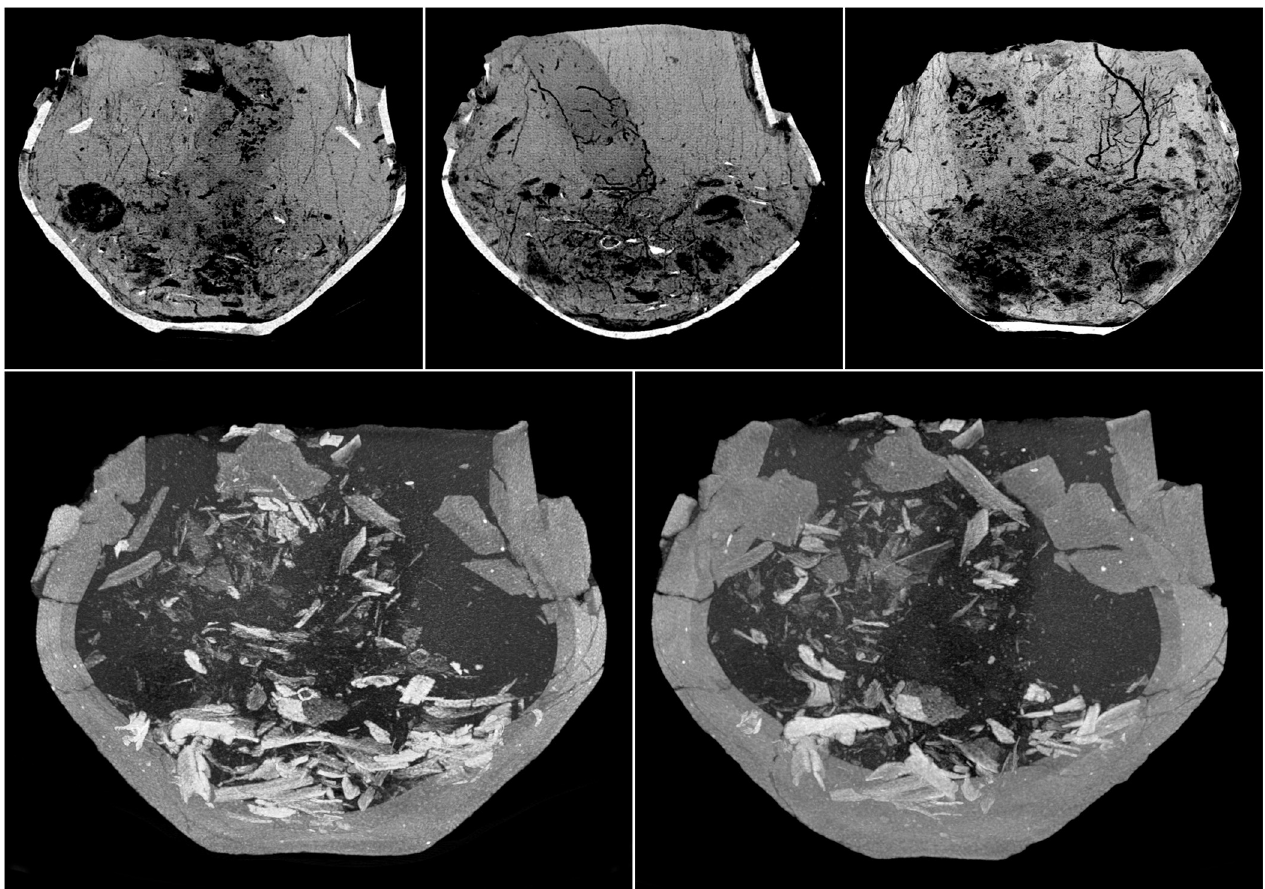
Fig 12. The CT imaging of the fill of the urn from grave 877. The top row shows the MinIP reconstruction of the urn fill with a visible system of burrows and ingrown plant roots. At the bottom, the MIP reconstruction of the displaced upwards and mixed burnt